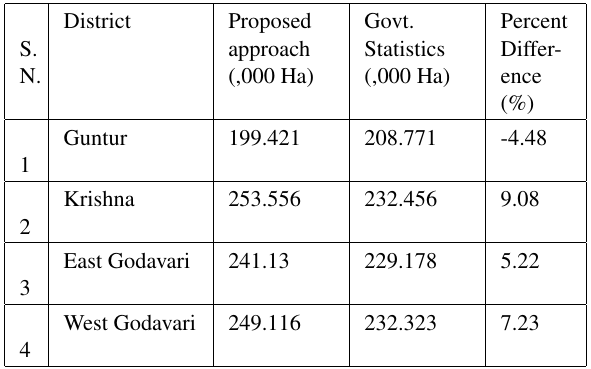
is less than 10%.